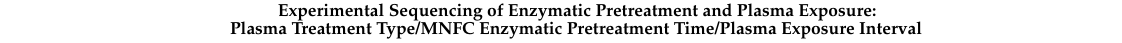
Table 1. Experimental nomenclature of samples, as used throughout the paper, displaying the enzymatic pretreatment time of pulp (min) and chosen plasma exposure time